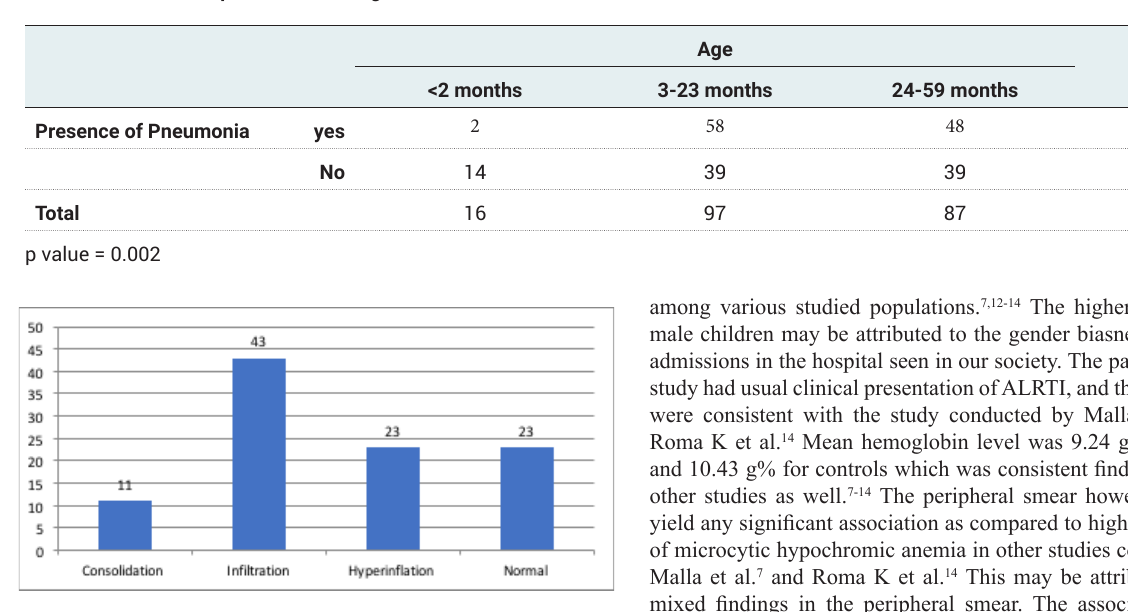
Figure 1: Chest X-ray findings Table3: Hemogram of study population